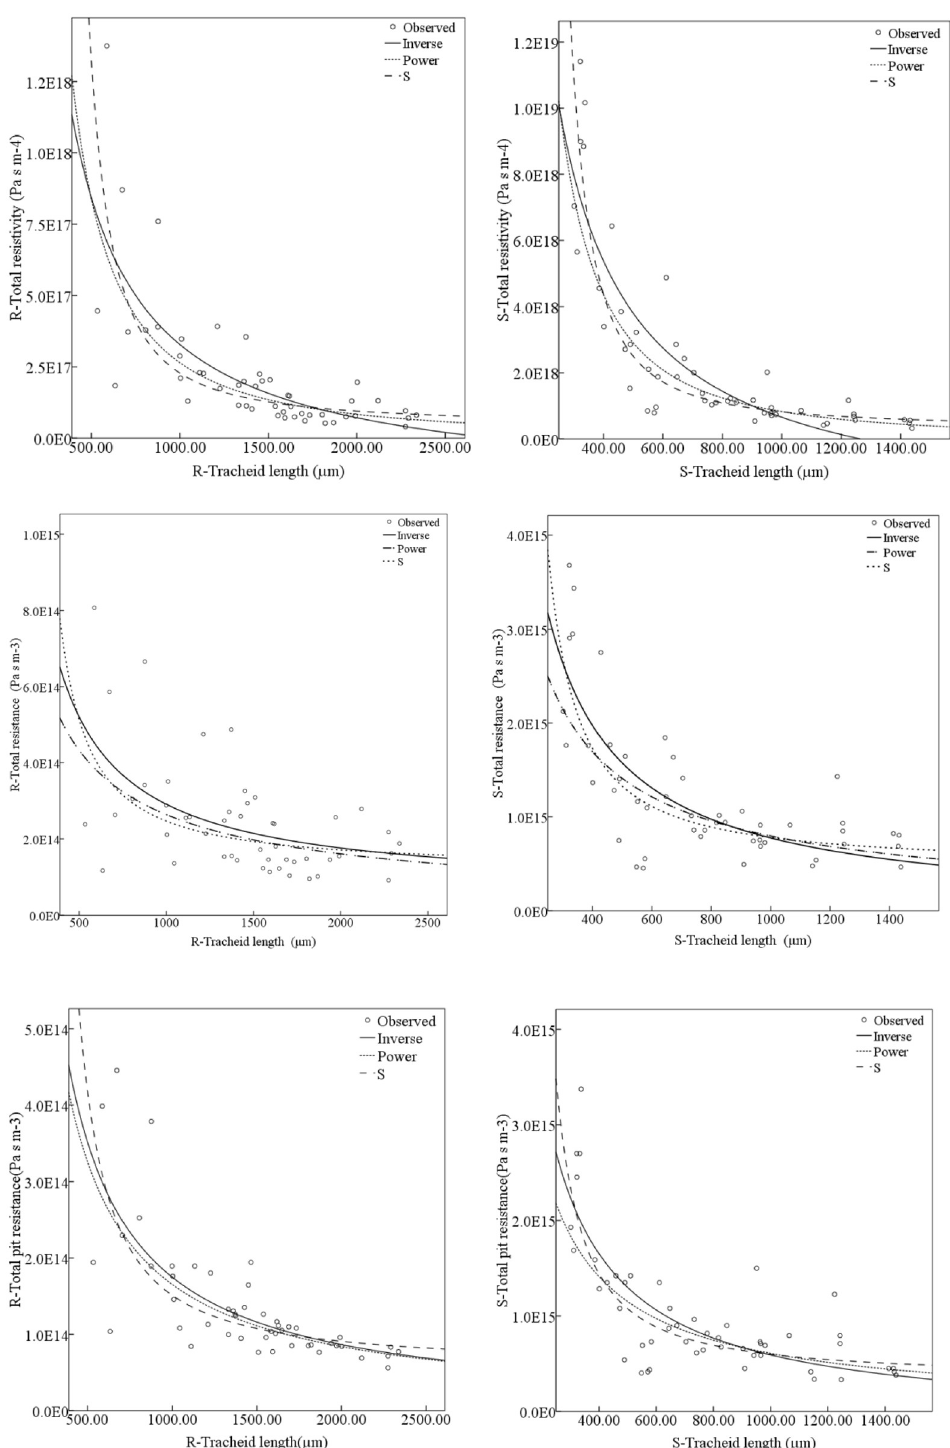
Fig 11. The relationship between total pit resistance, total resistivity and tracheids length. (a) Scatter plot of tracheid length and total pit resistance. (b) Scatter plot of tracheid length and total resistance. (c) Scatter plot of tracheid length and total